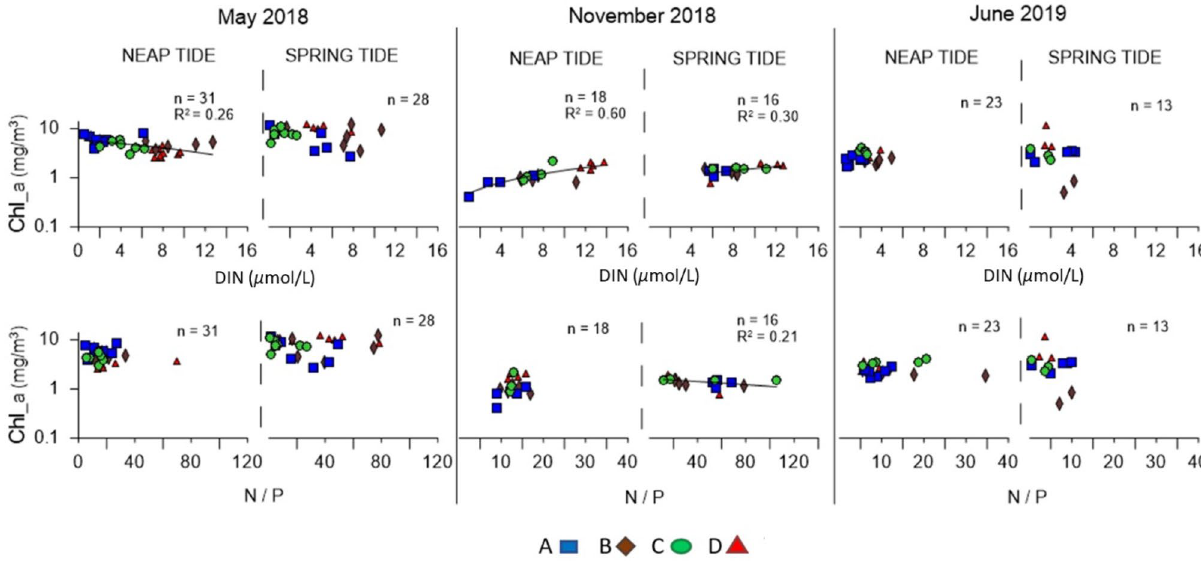
Figure 7. Relationships between the chlorophyll a and the dissolved inorganic nitrogen (DIN) and the N/P ratio, observed during the sampling campaigns in neap tide and spring tide conditions. Data collected at the surface. Chlorophyll a in log10 scale. Only R 2 > 0.2 and the respective lines are presented. The figure was produced using PRIMER 6 (6.1.16) + PERMANOVA (1.0.6) from PRIMER-e (https:// www. primer- e.